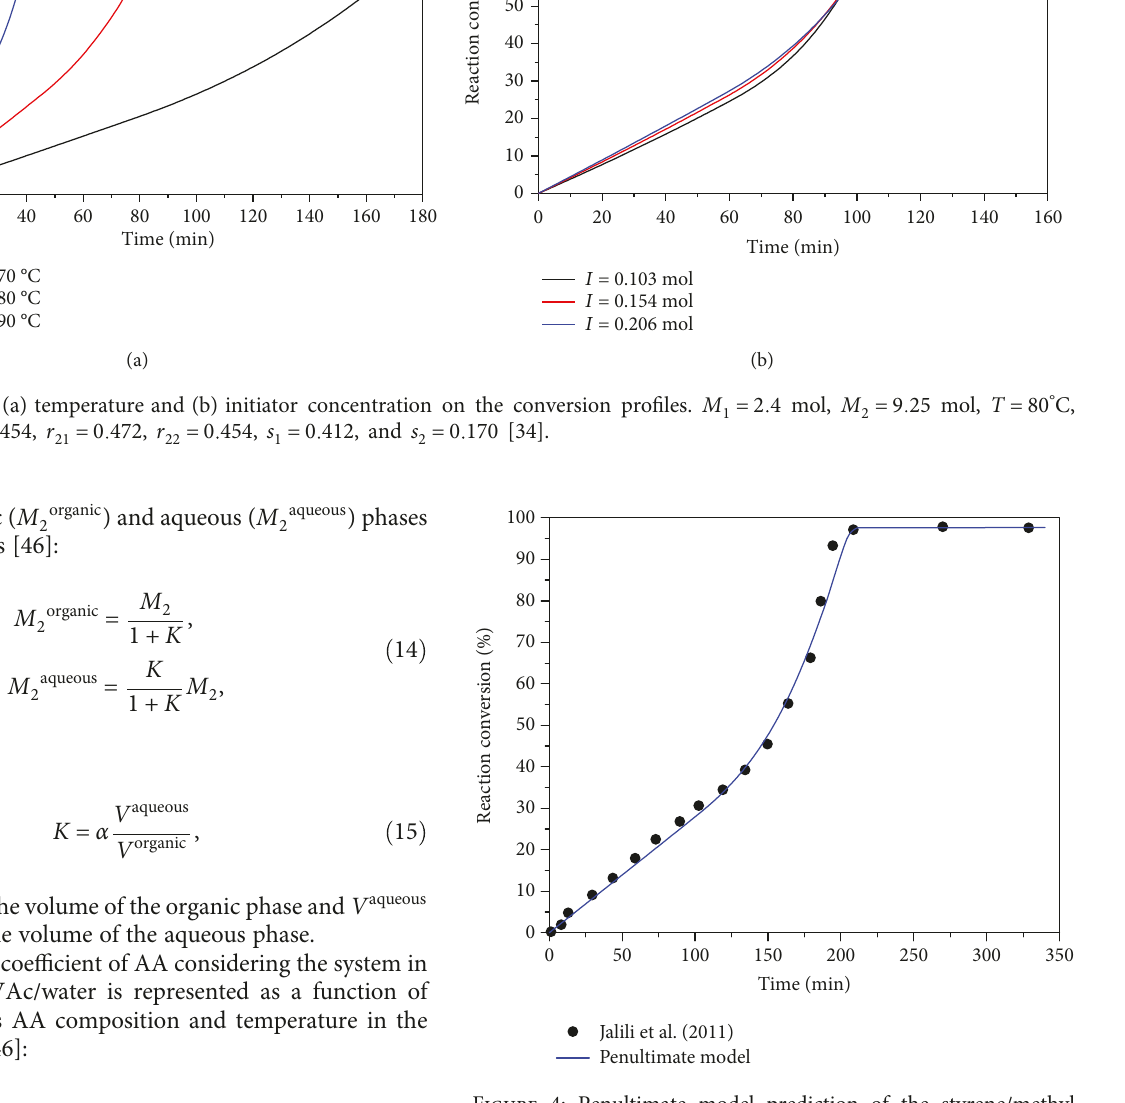
Figure 4: Penultimate model prediction of the styrene/methyl methacrylate bulk copolymerization carried out with BPO [43].